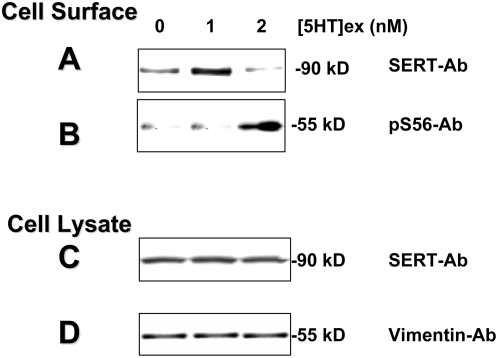
Effect of 5HT stimulation on SERT-vimentin association on platelet plasma membrane.0–2 nM 5HT-stimulated platelets were biotinylated with NHS-SS-biotin [15], [16], [19], and biotinylated plasma membrane proteins were retrieved on streptavidin beads. Half of biotinylated platelet membrane proteins were analyzed for SERT (A), and the other half was analyzed for anti-phosphovimentin-Ab (pS56-Ab) (B) with W/B. Neither SERT not pS56-Ab detected recognizable proteins in mock biotinylated controls (carried through the biotinylation procedure without the addition of the biotinylation reagent); therefore, they are not presented in the blots. Plasma 5HT levels had a biphasic effect on the plasma membrane expression of platelet SERT [16]. To correlate SERT-phosphovimentin association on the surface density of platelet SERT, the biotinylated platelet membrane proteins were analyzed with pS56-Ab. Plasma 5HT, only at high level, showed an association between phosphovimentin-SERT. Intracellular SERT (C) and vimentin (D) were determined by W/B analysis of non-bound material and also served as a loading control. All lanes contain protein recovered from the same number of platelets (1.5×108). Figures show representative images from 3 separate experiments.